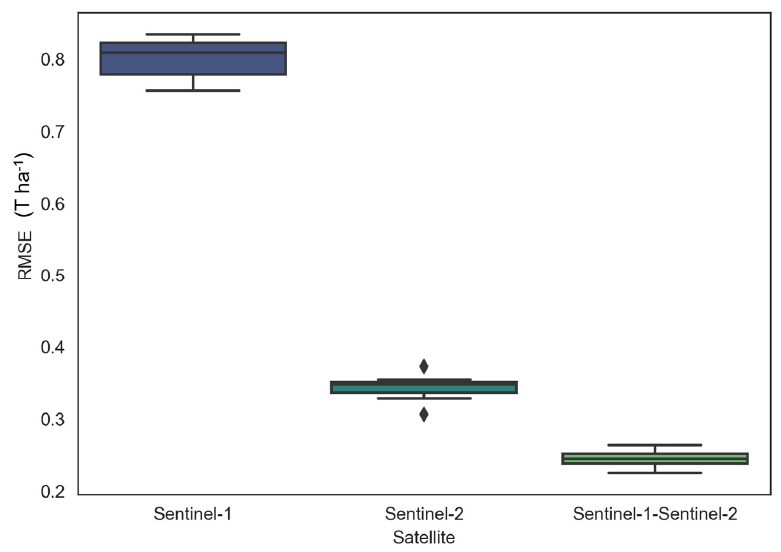
Figure 6. RMSE obtained using the CatBoost algorithm with data from S1 (Sentinel-1), S2 (Sentinel-2), and the combination of both (Sentinel-1 and Sentinel-2).